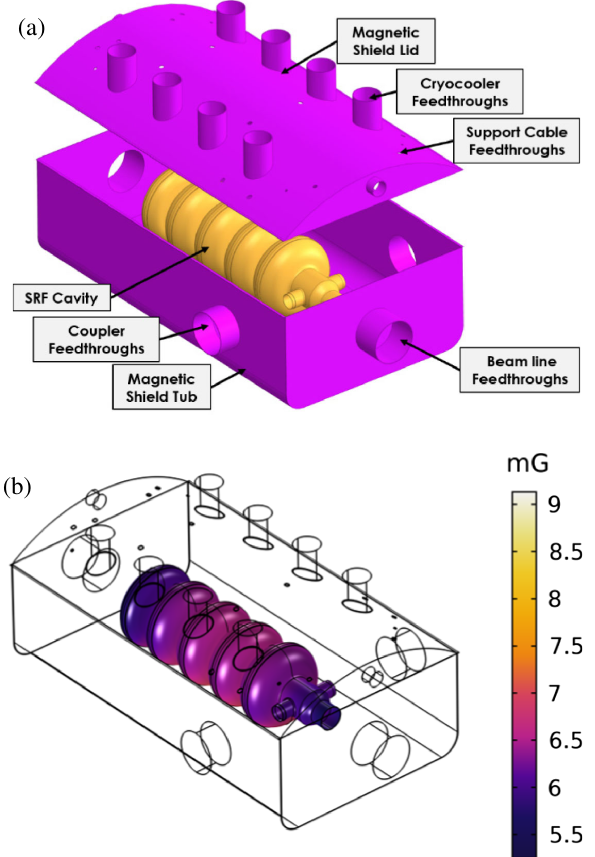
FIG. 23. (a) The exploded view of the magnetic shield shows that it is composed of two halves, a top lid, and a bottom tub which are attached at a small interface flange during assembly. Chimneys are attached around each feedthrough to improve shielding. (b) Magnetic flux density displayed along the surface of the SRF cavity, in the case where the beam line is oriented toward